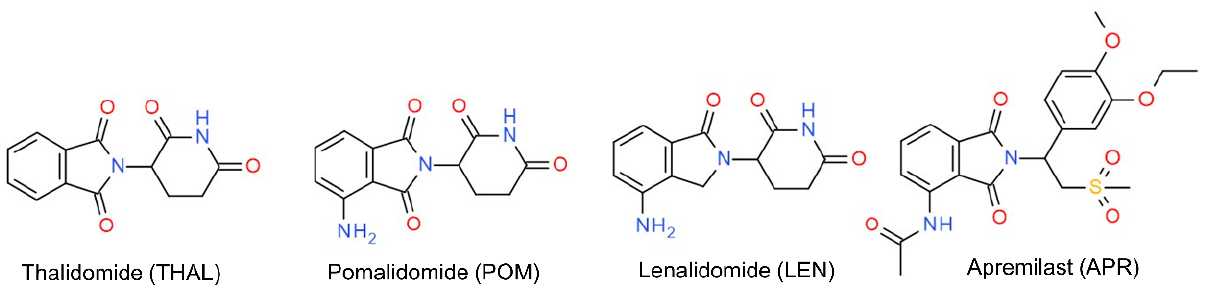
Figure 1. The structure of the investigated thalidomide derivatives.